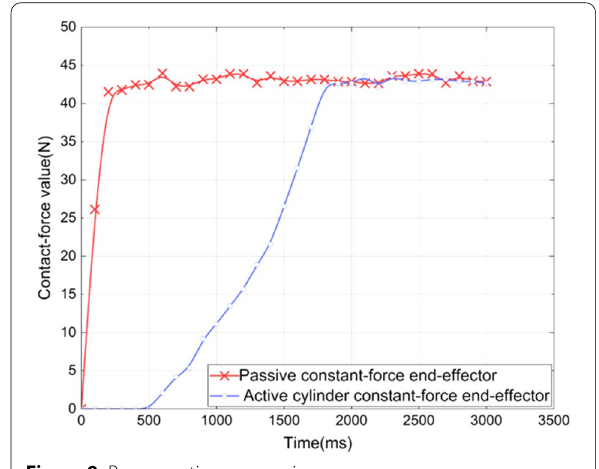
Figure 9 Response time comparison